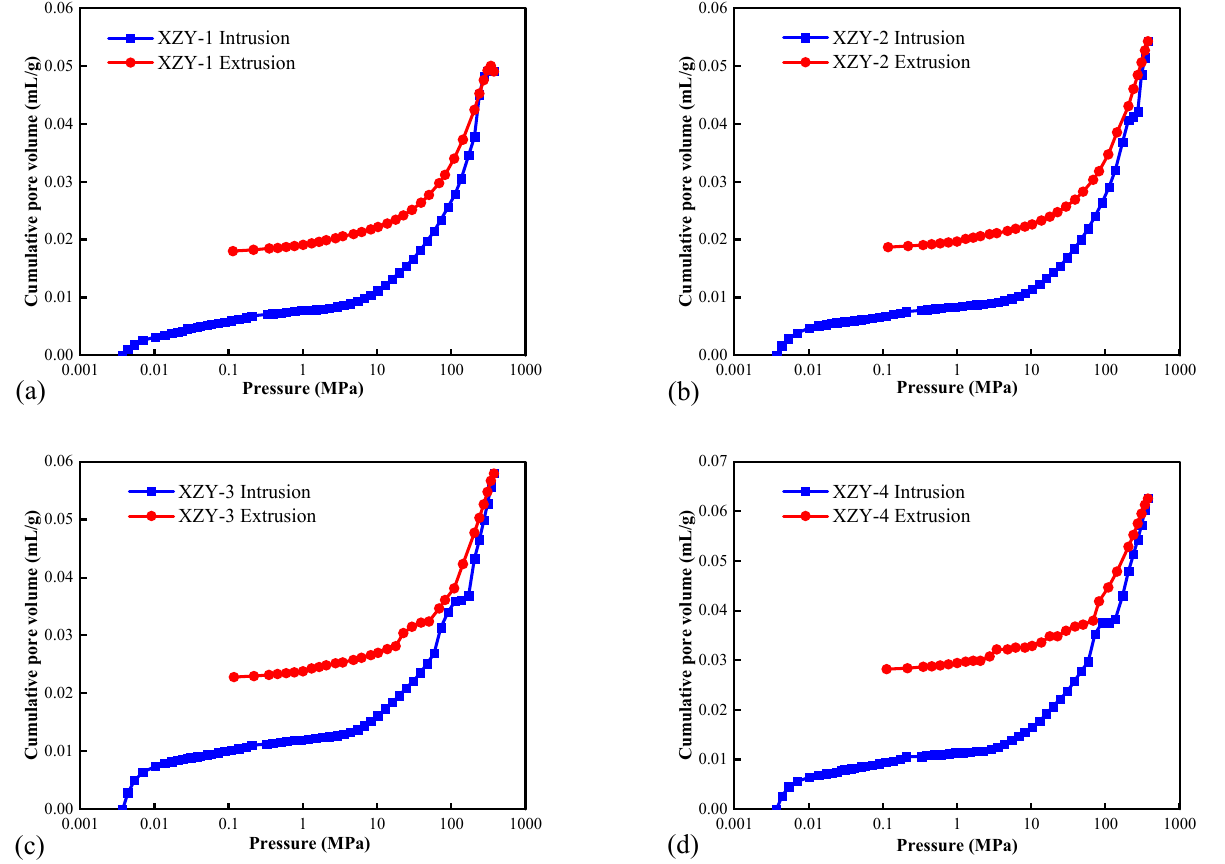
Figure 2. Mercury intrusion and extrusion curves of coal samples. ( a ) XZY-1; ( b ) XZY-2; ( c ) XZY-3; ( d ) XZY-4. Table 1. Gas adsorption experimental